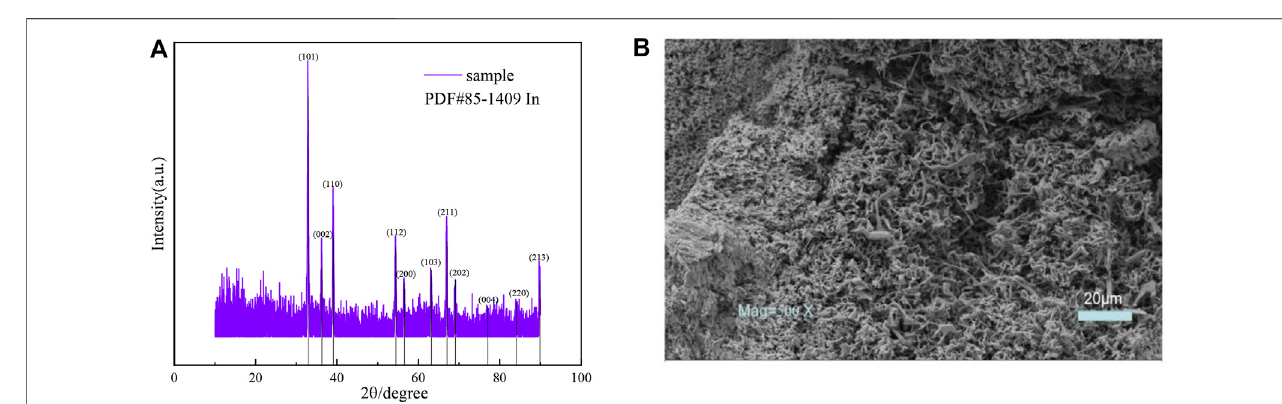
FIGURE 8 | (A) XRD patterns and (B) SEM image of indium deposited on Ti electrodes.